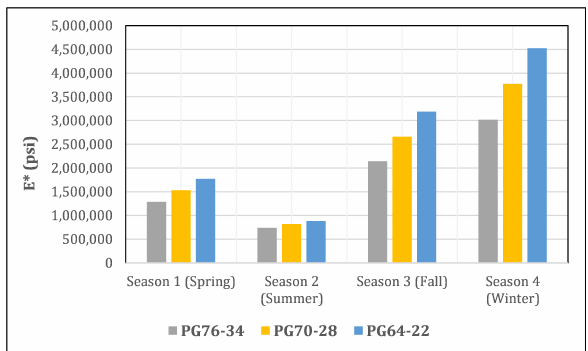
Figure 18: E* through seasons for different binder type.